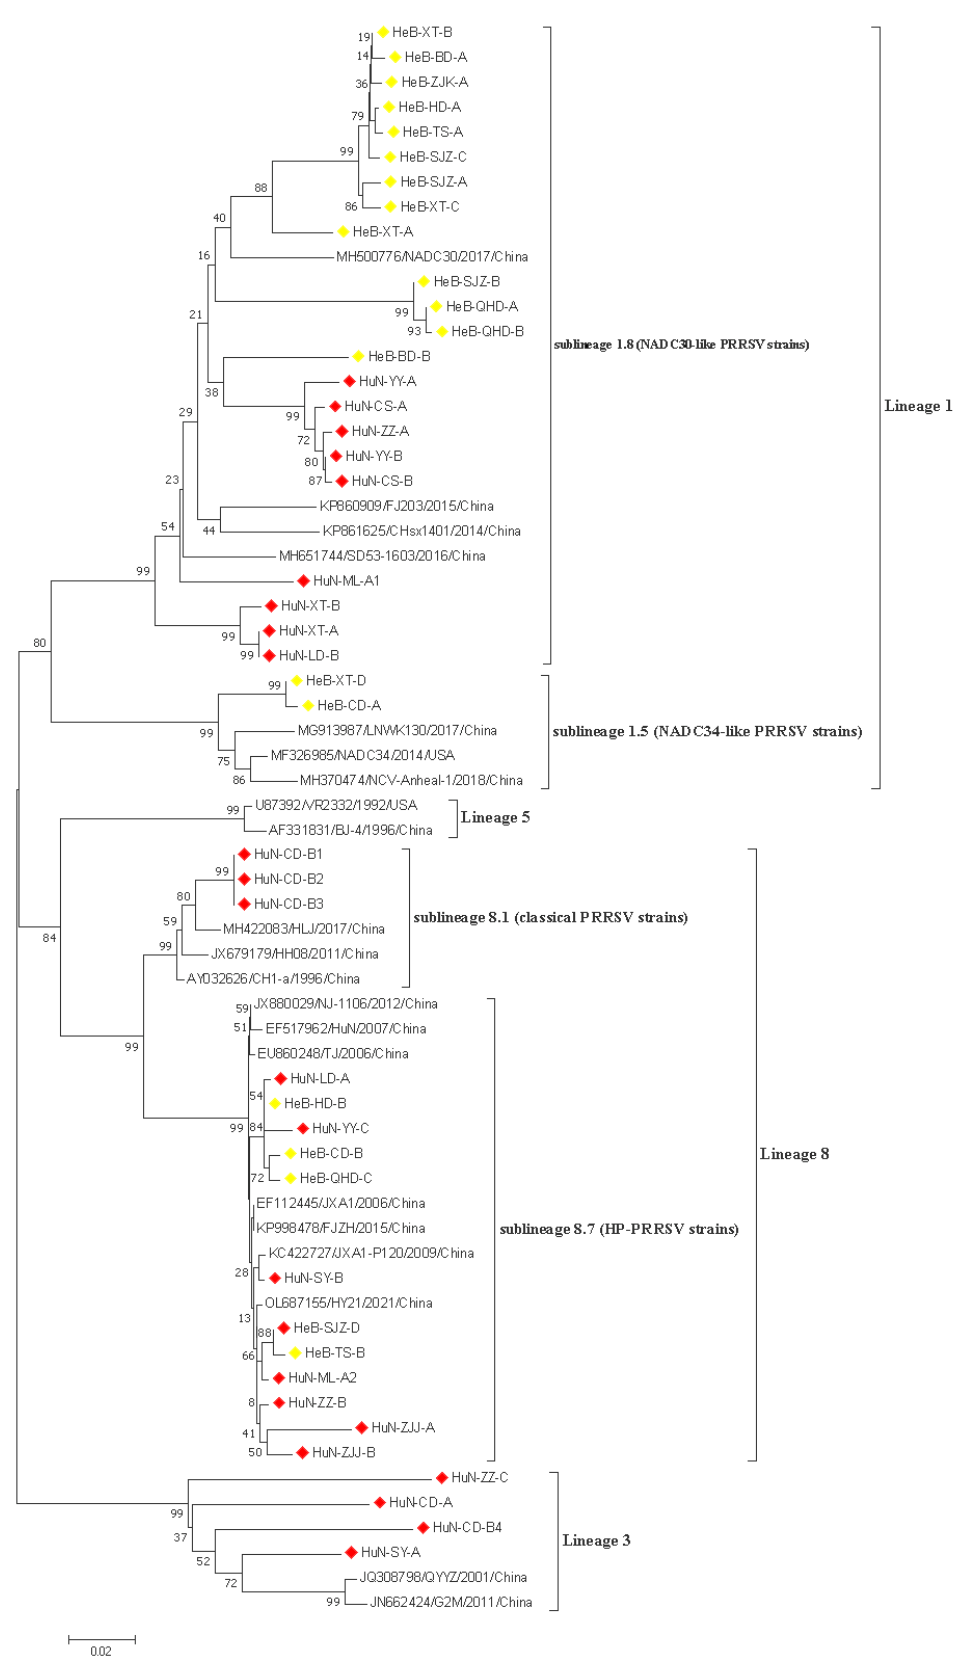
Figure 1. A phylogenetic tree based on the ORF5 nucleotide sequences was generated using